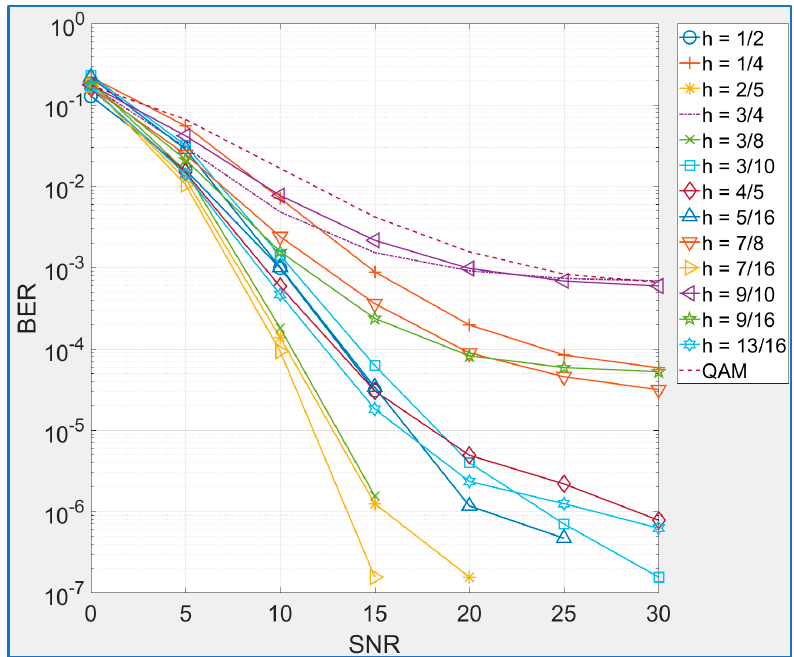
Figure 8. BER performance of CPM-GFDM vs. QAM-GFDM with J = 4 for matched filter receiver Figure 8 . BER performance of CPM-GFDM vs. QAM-GFDM with 𝐽 = 4 for matched filter receiver over AWGN over AWGN channels.